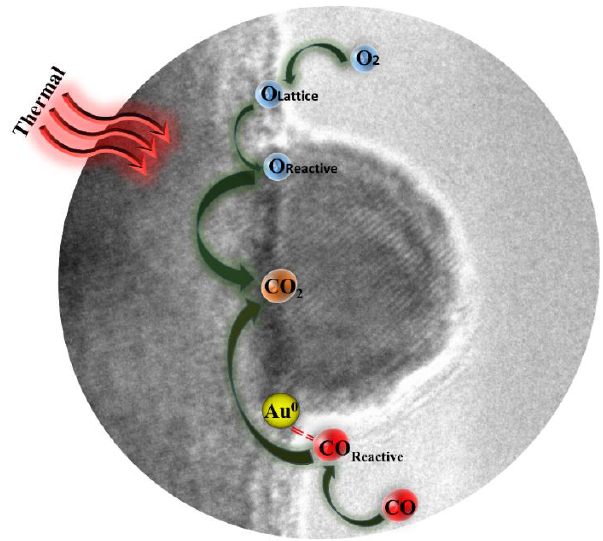
Figure 11. Schematic illustration of possible mechanism for CO oxidation by Au 1.0 /CuO-300 catalyst.